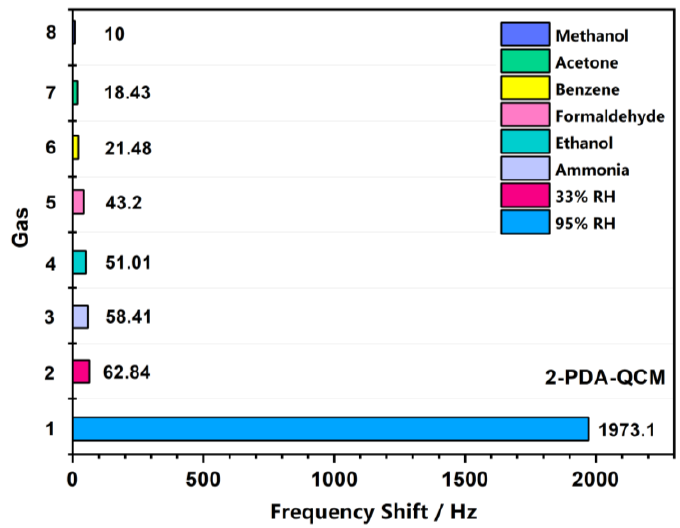
Figure 8. The selectivity histogram of 2-PDA-QCM.